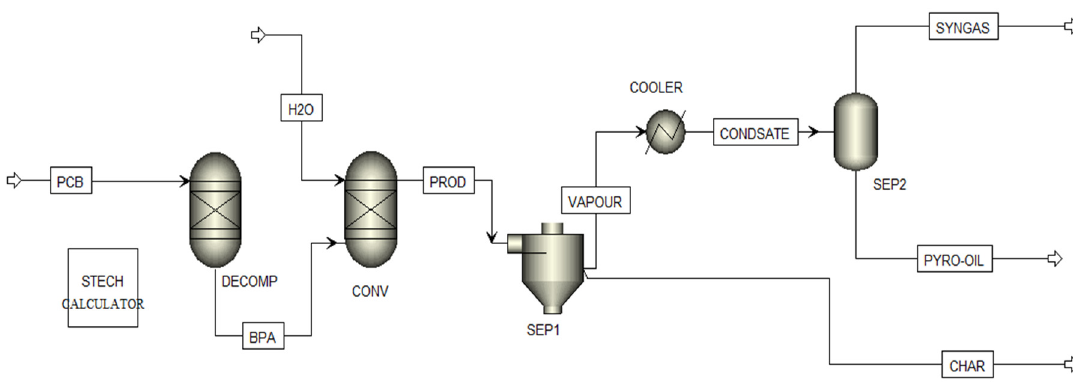
Figure 2. Flowsheet of the